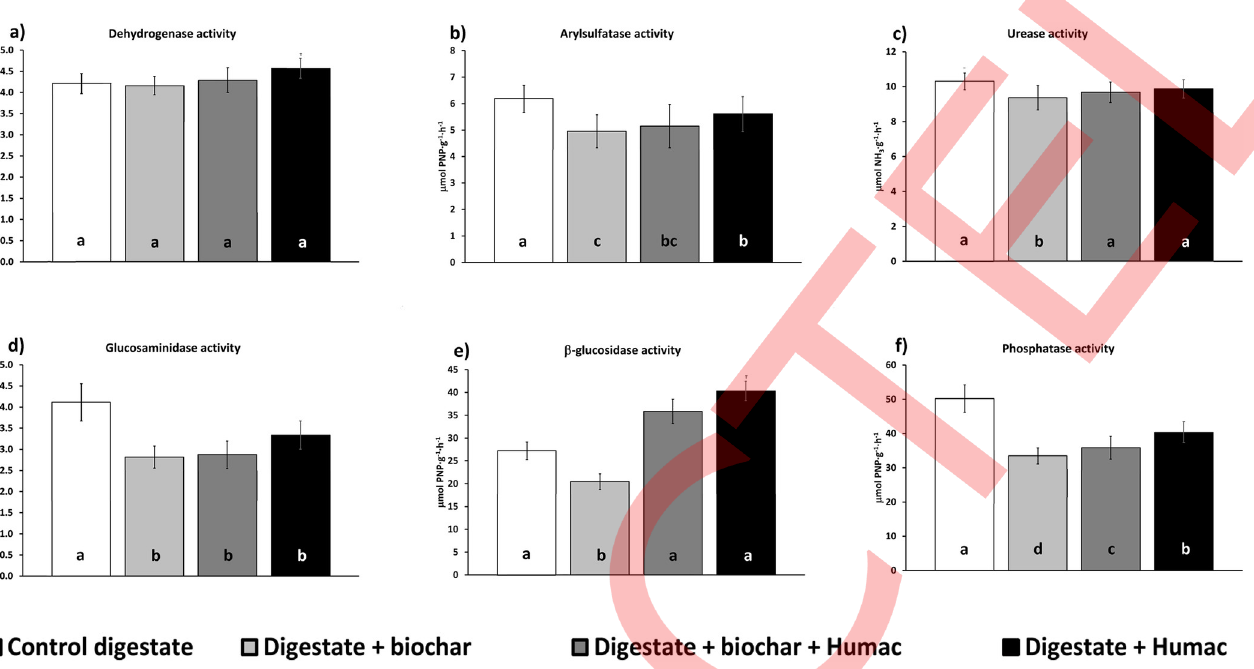
Fig 4. e-f Enzyme activities of: dehydrogenase (a) , arylsulfatase (b), urease (c) , N-acetyl- β -D-glucosaminidase (d), β -glucosidase (e), phosphatase (f) –M with CI 95% (error bars). Different letters indicate statistically significant differences in MANOVA at p � 0.05.